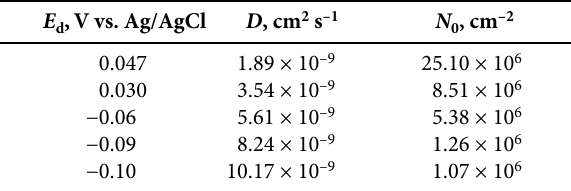
Table 1 . The experimental data of the CA electrodeposition of Mo onto Pt